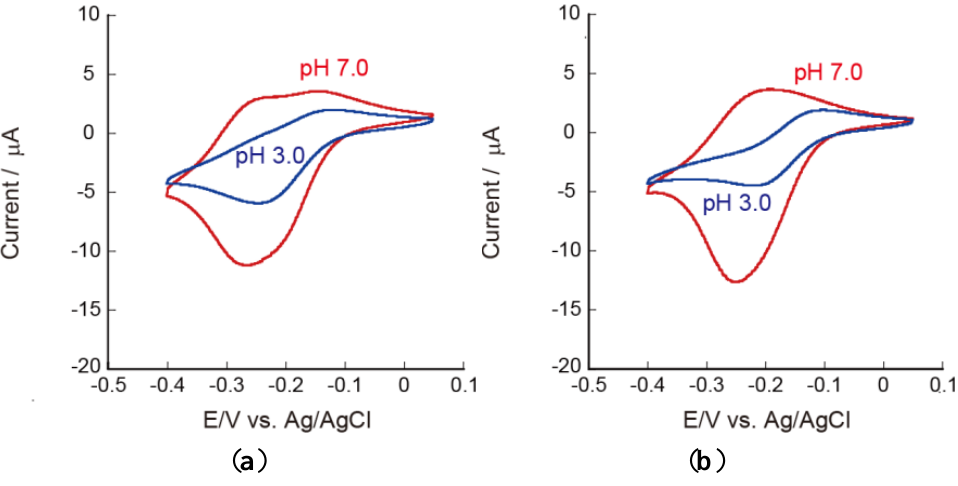
Figure 8. CVs of Ru(NH electrodes at pH 3.0 (blue) and pH 7.0 (red). The LbL films were prepared at pH 7.0.